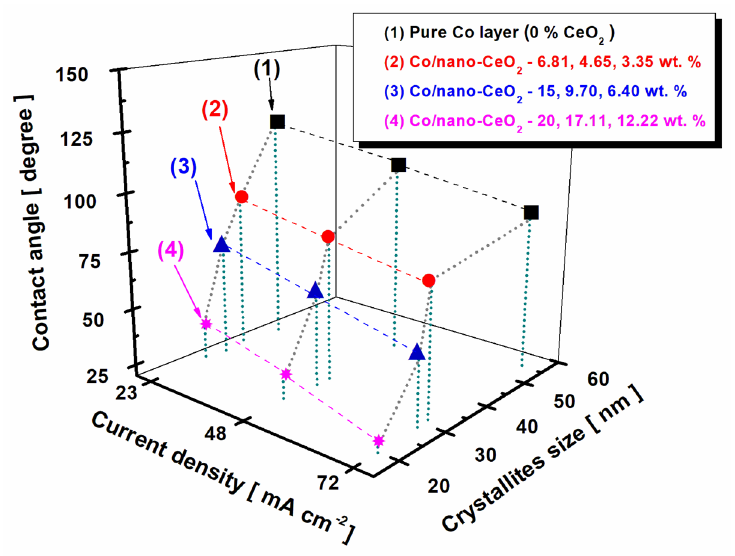
Figure 8. Correlation between nanostructuring effects of nano-CeO 2 embedded into a cobalt matrix and the contact angle of resulting nanostructured